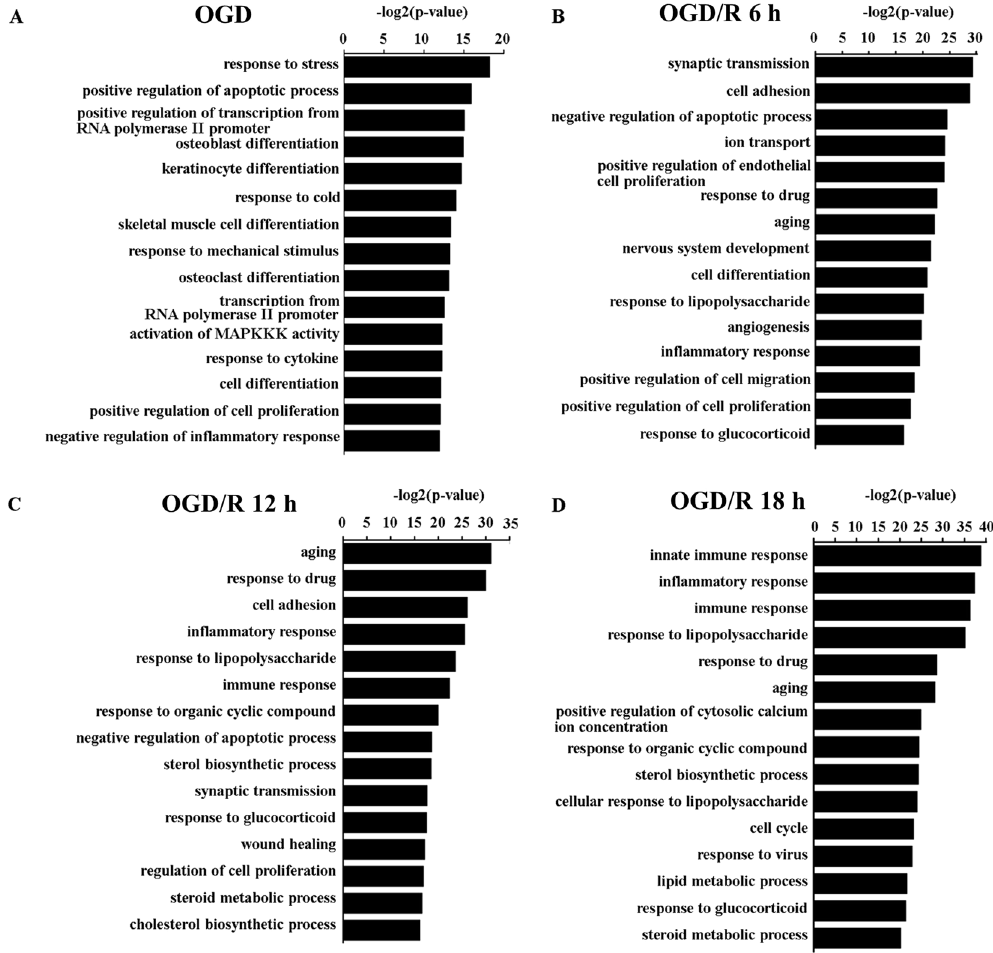
Figure 2. Gene ontology (GO) enrichment analysis of genes differentially expressed in primarily cultured neurons upon oxygen glucose deprivation (OGD), and OGD with reperfusion. ( A – D ) GO terms with most significant P-value were shown for OGD 45 min/R 0 h vs OGD 0 min/R 0 h ( A ); OGD 45 min/R 6 h vs OGD 45 min/R 0 h ( B ); OGD 45 min/R 12 h vs OGD 45 min/R 0 h ( C ); and OGD 45 min/R 18 h vs OGD 45 min/R 0 h ( D